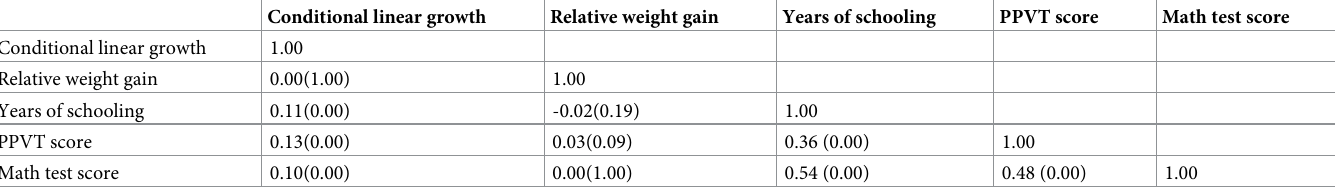
Table 2. Correlation matrix.